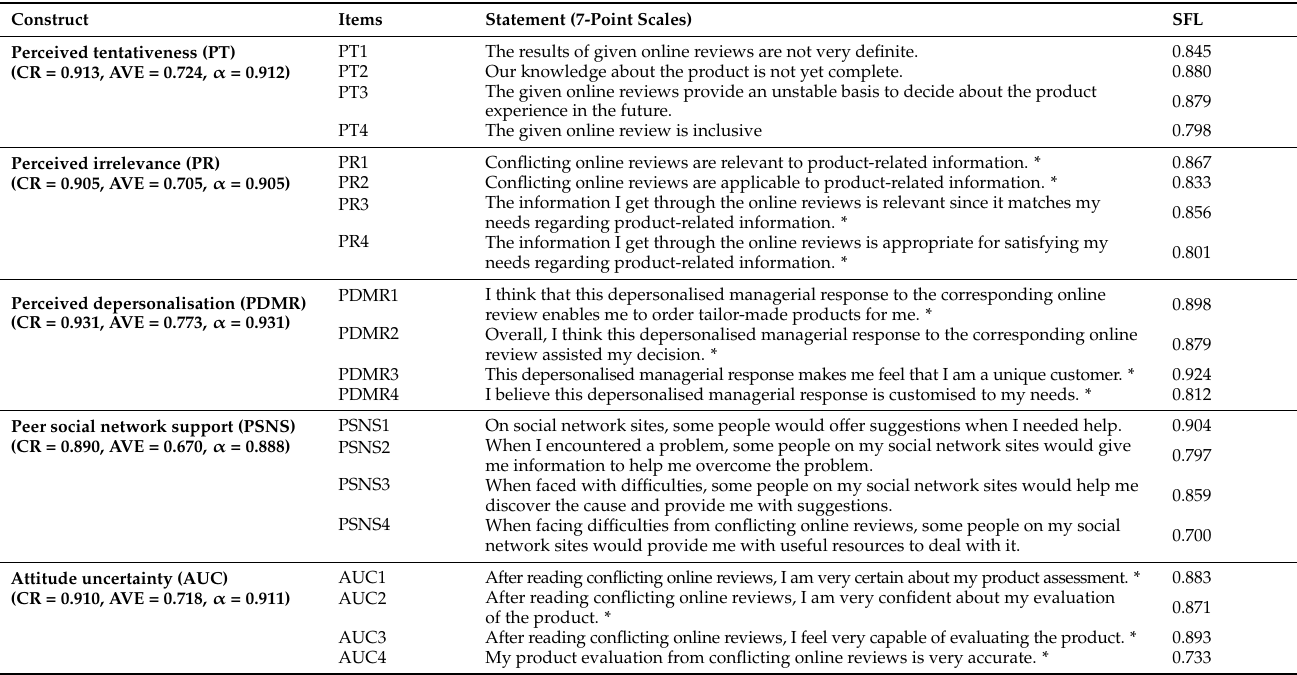
Table 2. Summary of measurement